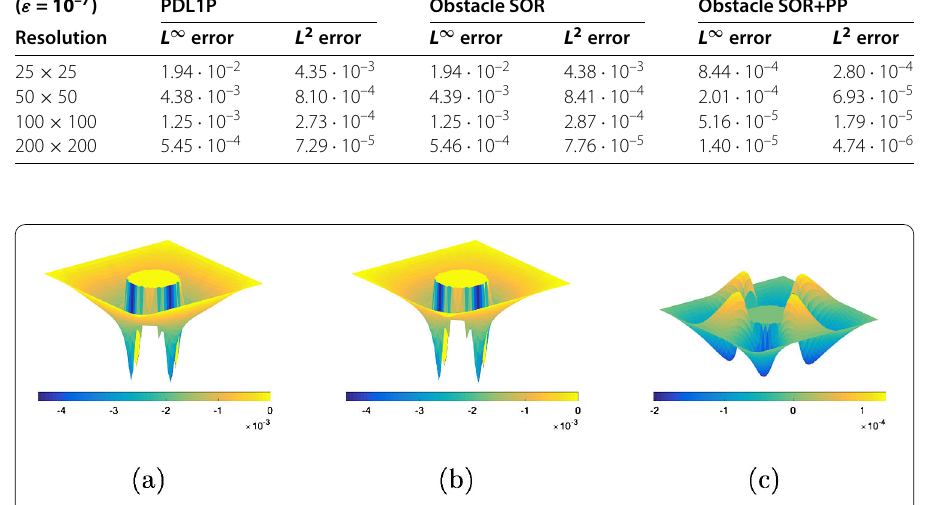
Table 6 L ∞ and L 2 error comparisons for the suggested post-process, applied to the linear problem with ϕ = ϕ 2 ( ε = 10 –7 ) PDL1P Obstacle SOR Obstacle SOR + PP Resolution L ∞